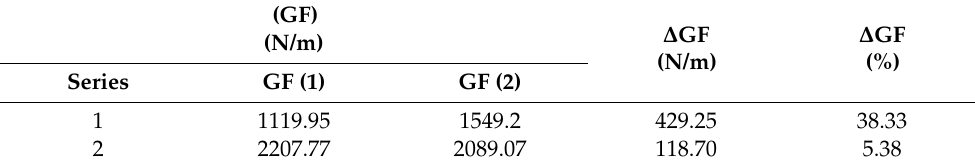
Table 6. Fracture energy (GF) computed through the studied models